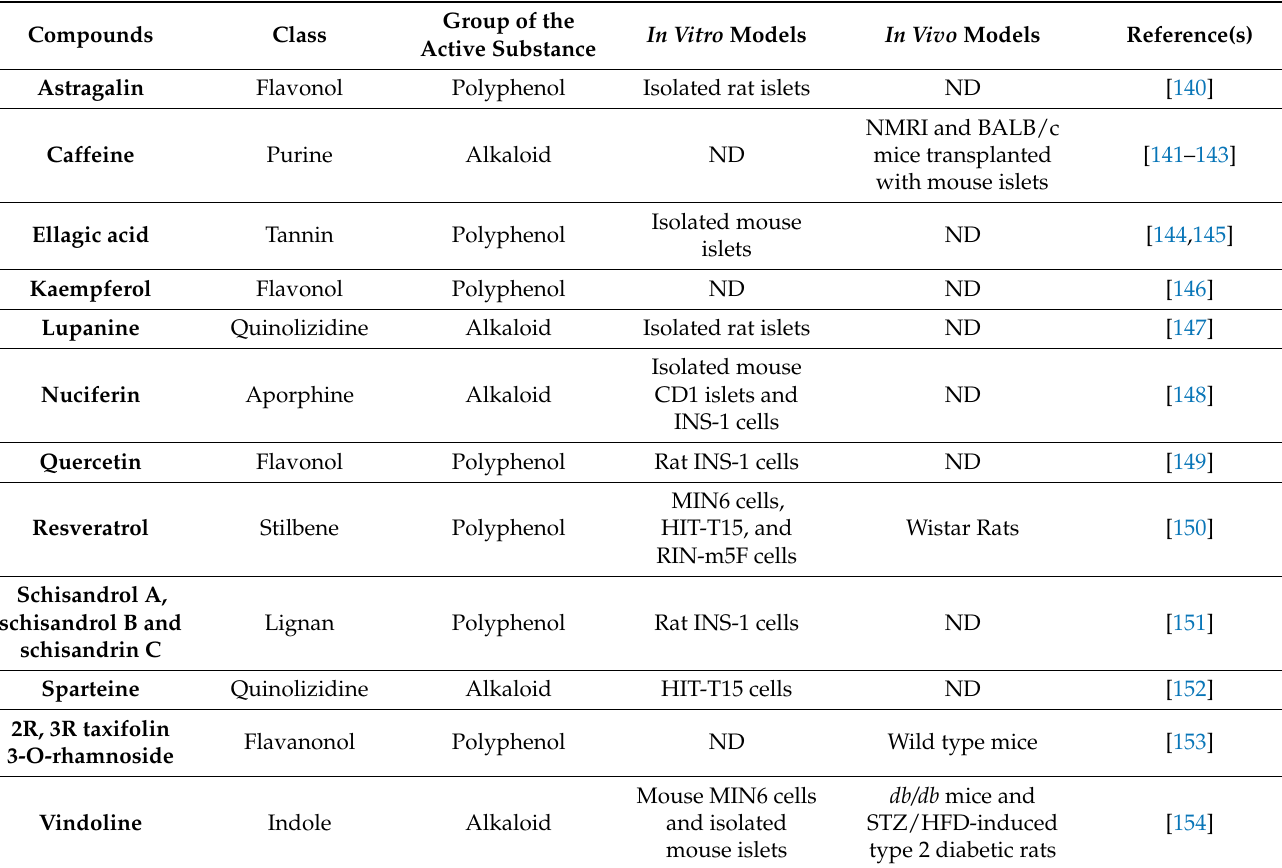
Figure 3. Classification of Alkaloids. Table 4. Polyphenols and alkaloids that stimulate insulin secretion in a mechanism that requires the closure of K + ATP channels.